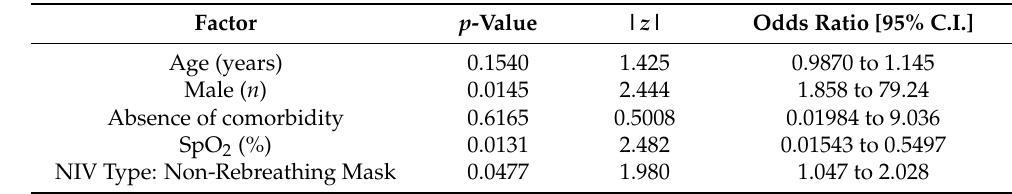
Table 2. Multivariate analysis for analysis of independent factors associated with the need or not for intubation after starting to use the